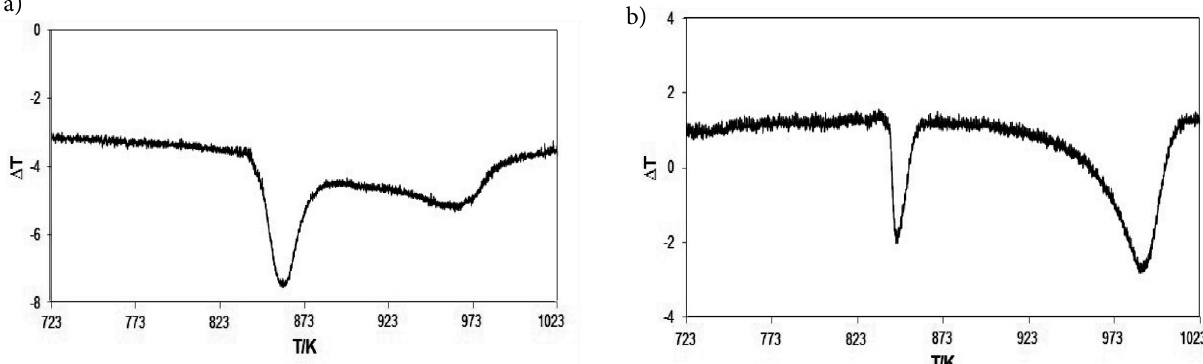
Figure 6 . The DTA results in ∆T – T coordinates for (SnAs) 0.4 (GeAs) 0.6 (a) and (SnAs) 0.15 (Ge 0.4 As 0.6 ) 0.85 (b)